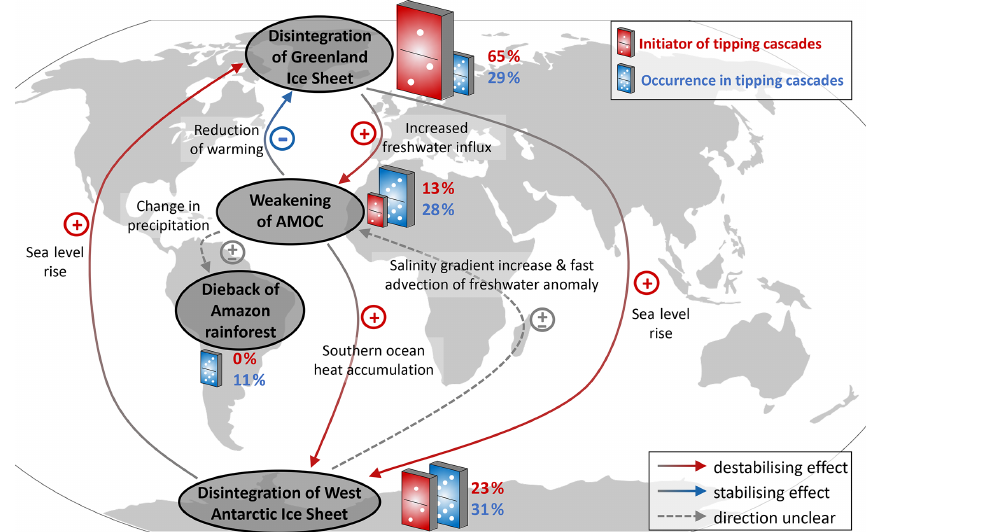
Figure 1. Interactions between climate tipping elements and their roles in tipping cascades. The Greenland Ice Sheet, the West Antarctic Ice Sheet, the Atlantic Meridional Overturning Circulation (AMOC) and the Amazon rainforest are depicted along with their main interactions (Kriegler et al., 2009). The links between the tipping elements are colour coded, where red arrows depict destabilising and blue arrows depict stabilising interactions. Where the direction is unclear, the link is marked in grey. A more thorough description of each of the tipping elements and the links can be found in Tables 1 and 2 as well as in Sect. 2. Where tipping cascades arise, the relative size of the dominoes illustrates how many ensemble members the respective climate component initiates tipping cascades in (red domino) or how many tipping cascades the respective climate component occurs in (blue domino). Standard deviations for these values are given in Fig. S1a and b. Generally, the polar ice sheets are found to more frequently take on the role of cascade initiators than the AMOC and Amazon